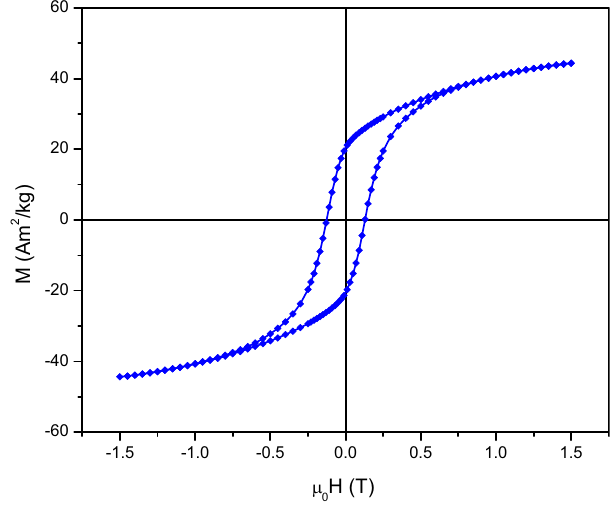
Figure 5. Room-temperature hysteresis loops of as-synthesized SFO